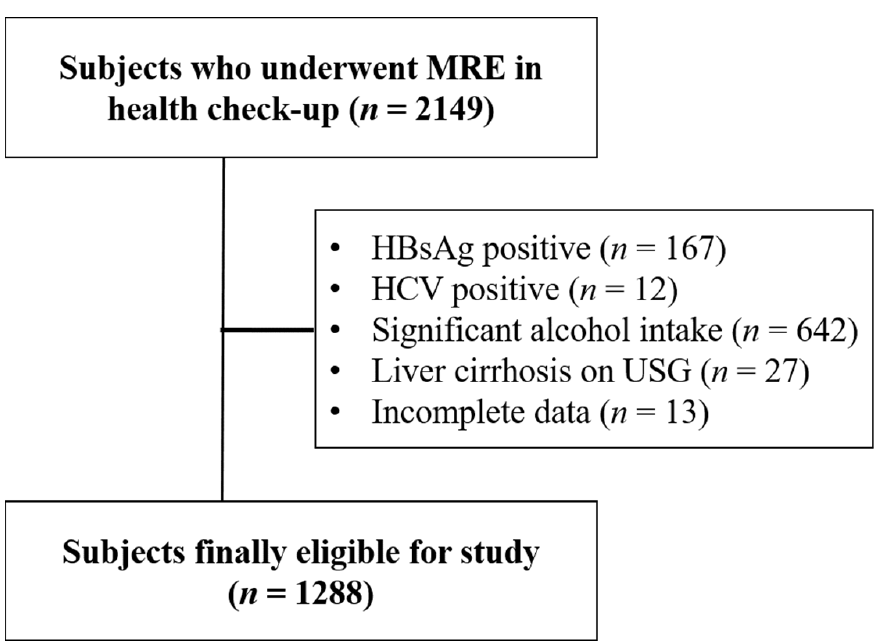
Figure 1. Flow chart of study participants. MRE, magnetic resonance elastography.